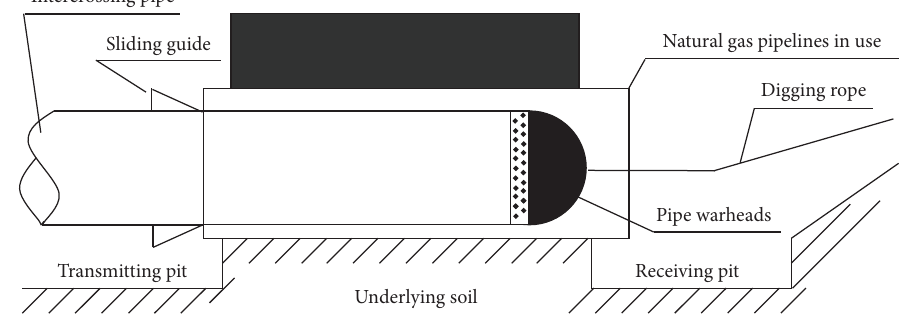
Figure 11: Construction technology processes of the intercrossing method in repairing buried PE pipelines [50].